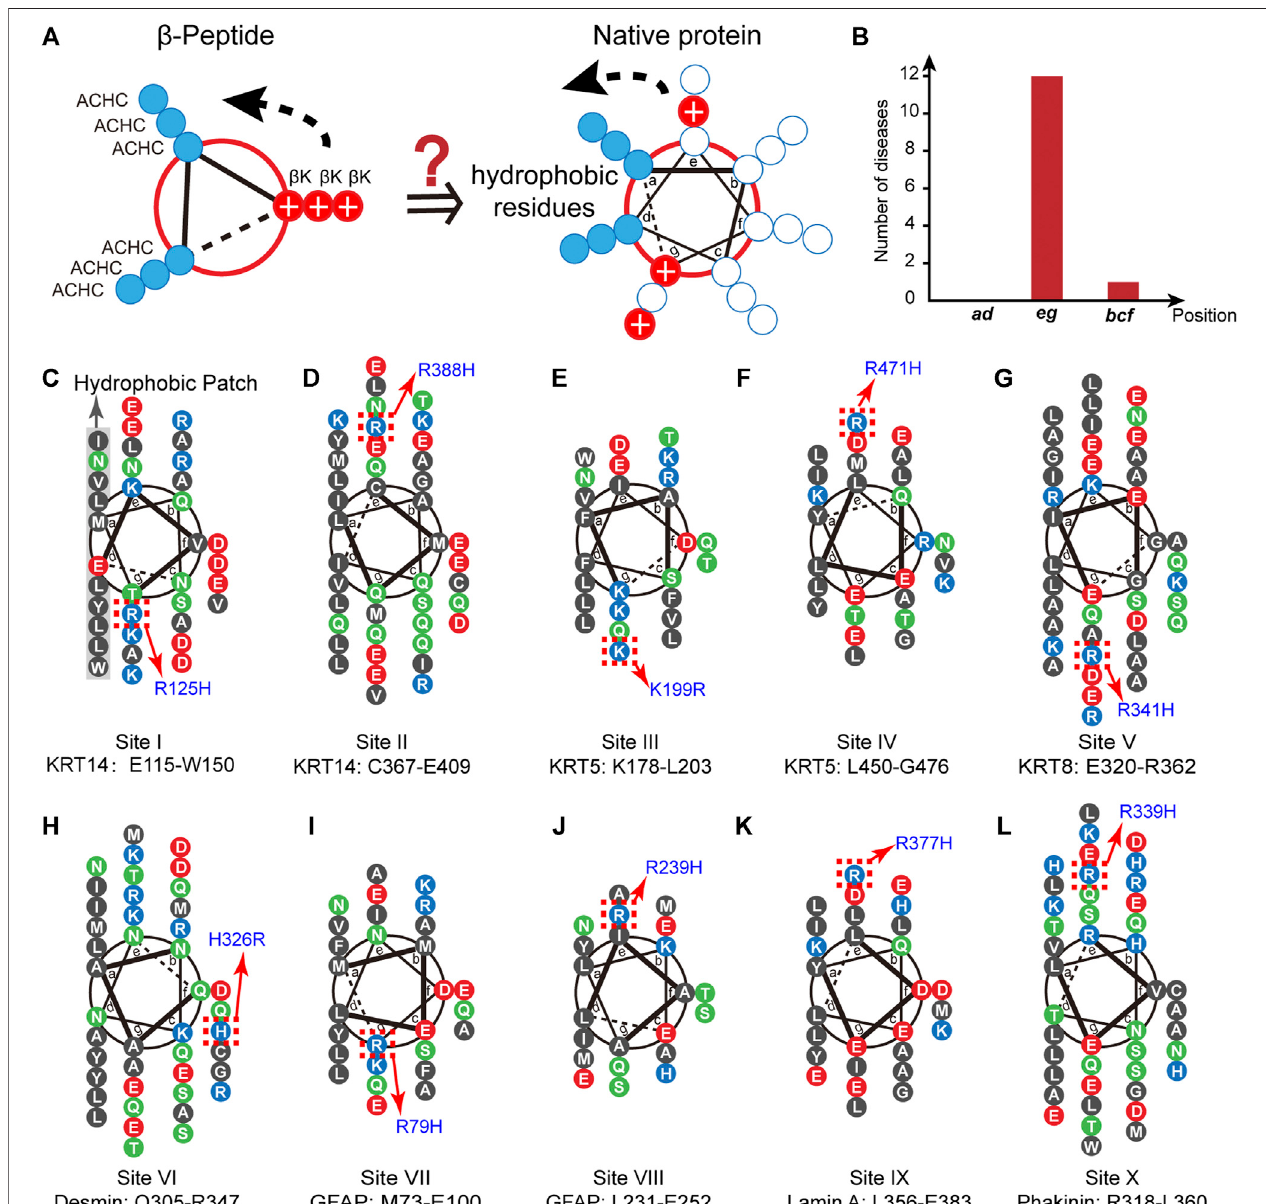
FIGURE1| TheconservationofproximalcationicsidechainintheIFsuperfamily. (A) Thehelix-wheeldiagramsofagloballyamphiphilic β 3 -peptide (left) andnative α -helical peptide (right) . The solid blue discs represent nonpolar residues and the solid red discs with a white plus sign represent the side chains of positively charged residues.( B )Thedistributionofthenumberofdiseasesassociatedwithsinglecation-to-cationsubstitution. (C – L) Helix-wheeldiagramsofthecoil1AdomainsinKRT14 ( C,D ,siteIandII)inthetypeIfamily,KRT5( E,F ,siteIIIandIV)andKRT8( G ,siteV)inthetypeIIfamily,Desmin( H ,siteVI)andGFAP( I,J ,siteVIIandVIII)inthetype IIIfamily,LaminA( K ,siteIX)inthetypeVfamily,andphakinin( L ,siteX)inthetypeVIfamily.Blue,cationicresidues;red,anionicresidues;black,nonpolarresidues;green, polar and uncharged residues. The hotspots in the homology sequences are denoted by red dotted boxes.